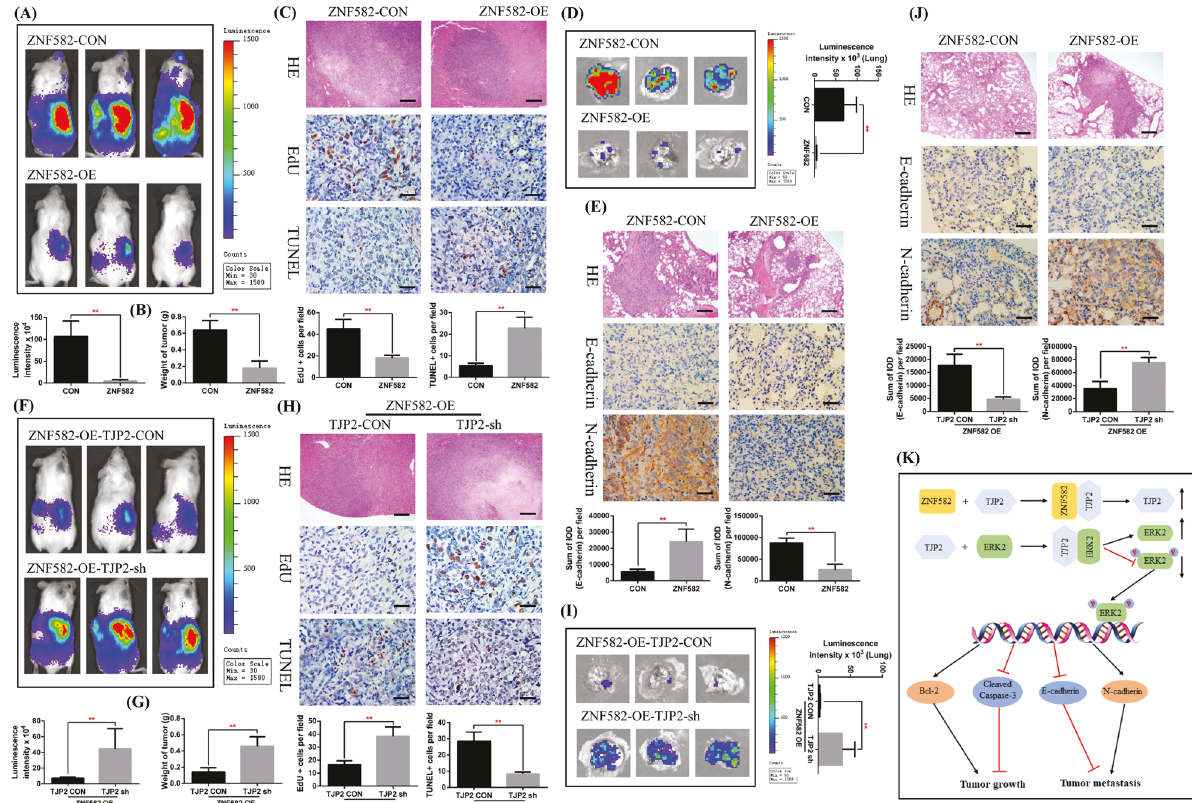
Fig. 8 ZNF582 overexpression inhibits ccRCC cell growth and metastasis by regulating TJP2 in vivo. A Representative bioluminescence imaging of ZNF582 overexpression and control groups and quanti fi cation of these bioluminescence imaging. B Quanti fi cation of the tumor weight of ZNF582 overexpression and control groups. C Representative picture of HE (100X, Bar: 100 um), EdU and TUNEL expression (400X, Bar: 25 um) in the kidney tumors of ZNF582 overexpression and control groups and quanti fi cation the expression of EdU and TUNEL. D Representative lung ex vivo bioluminescence imaging of ZNF582 overexpression and control groups and quanti fi cation of ex vivo imaging. E Representative picture of HE (100X, Bar: 100 um), E-cadherin and N-cadherin expression (400X, Bar: 25 um) in the lung metastases of ZNF582 overexpression and control groups and quanti fi cation of these picture. IOD: integrated optical density. F Representative bioluminescence imaging of TJP2 knockdown and control groups and quanti fi cation of these bioluminescence imaging. G Quanti fi cation of the tumor weight of TJP2 knockdown and control groups. H Representative picture of HE (100X, Bar: 100 um), EdU and TUNEL expression (400X, Bar: 25 um) in the kidney tumors of TJP2 knockdown and control groups and quanti fi cation the expression of EdU and TUNEL. I Representative lung ex vivo bioluminescence imaging of TJP2 knockdown and control groups and quanti fi cation of ex vivo imaging. J Representative picture of HE (100X, Bar: 100 um), E-cadherin and N-cadherin expression (400X, Bar: 25 um) in the lung metastases of TJP2 knockdown and control groups and quanti fi cation of these picture. IOD: integrated optical density. K Schematic model of ZNF582 overexpression up-regulates TJP2 protein expression, which leads to up-regulation of ERK2 protein and down-regulation of p-ERK2, therefore suppressing the growth and metastasis of ccRCC. All result data are represented as mean ±